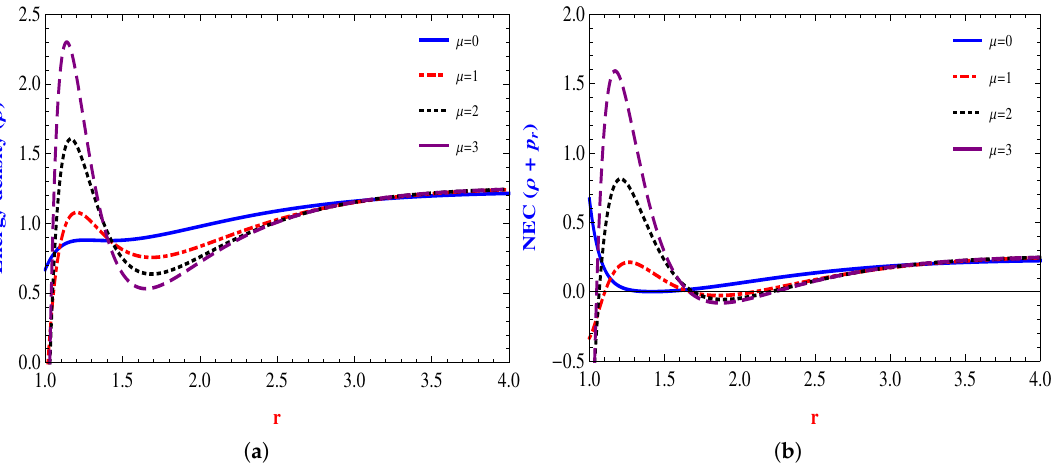
Figure 7. Plots: ( a ) Energy density ( ρ ) and ( b ) Radial NEC ( ρ + p r ) with throat radius r 0 = 1, α = 1, β = 1, and γ = 2 in f ( Q ) = α Q 2 + β Q + γ